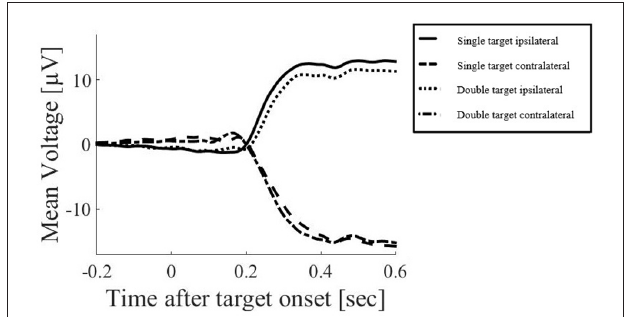
FIGURE 2 | Example of electroencephalogram (EEG) responses in the above mentioned electrode clusters around FC1 and FC2 over a long time window, averaged across all subjects. Only the saccadic response condition is displayed here, demonstrating the major voltage deflections associated with the saccade (occurring at and after 200 ms in this